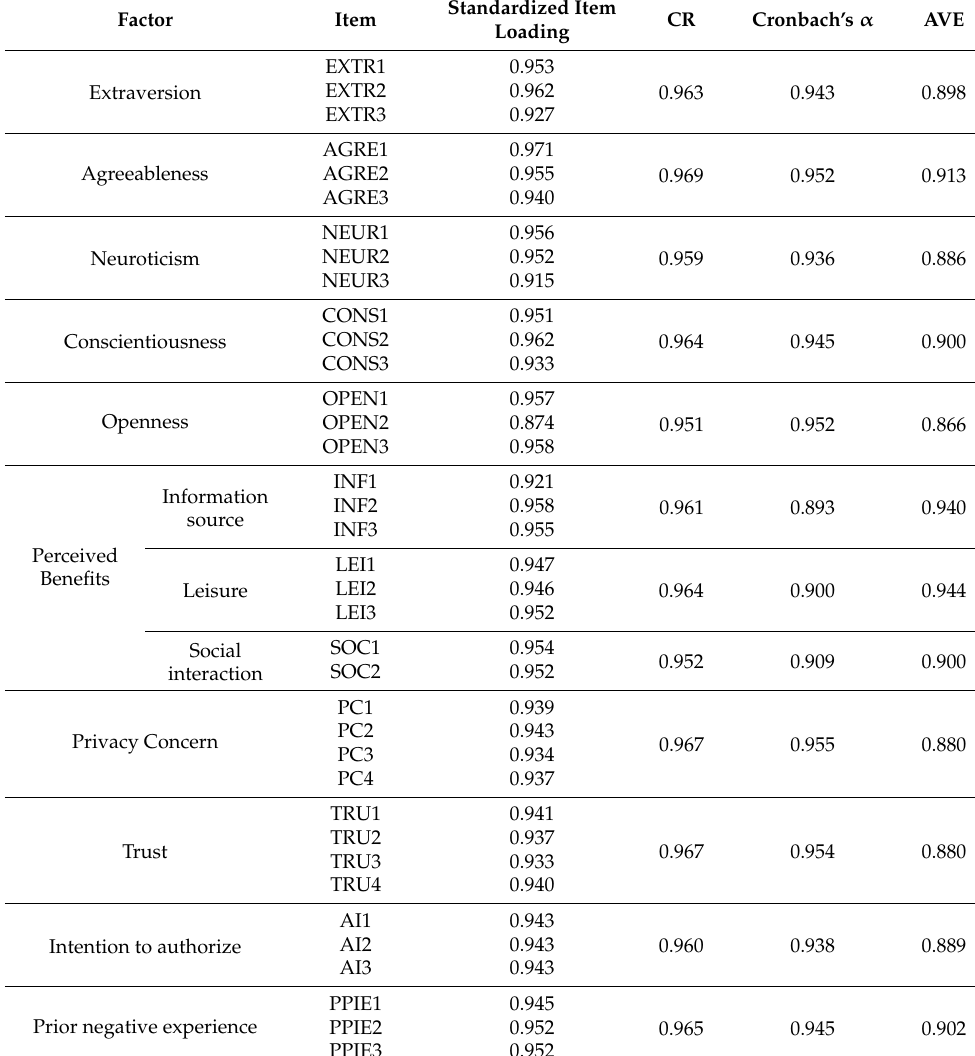
Table 3. Standardized item loadings, AVE, CR and Alpha values.